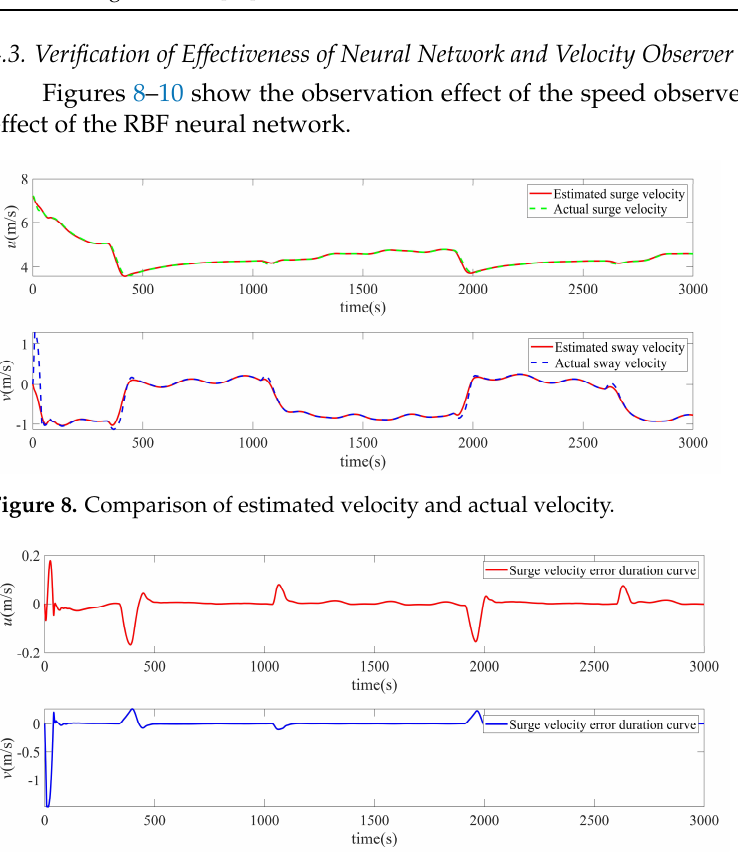
Table 3. Quantitative performance comparison of both algorithms.